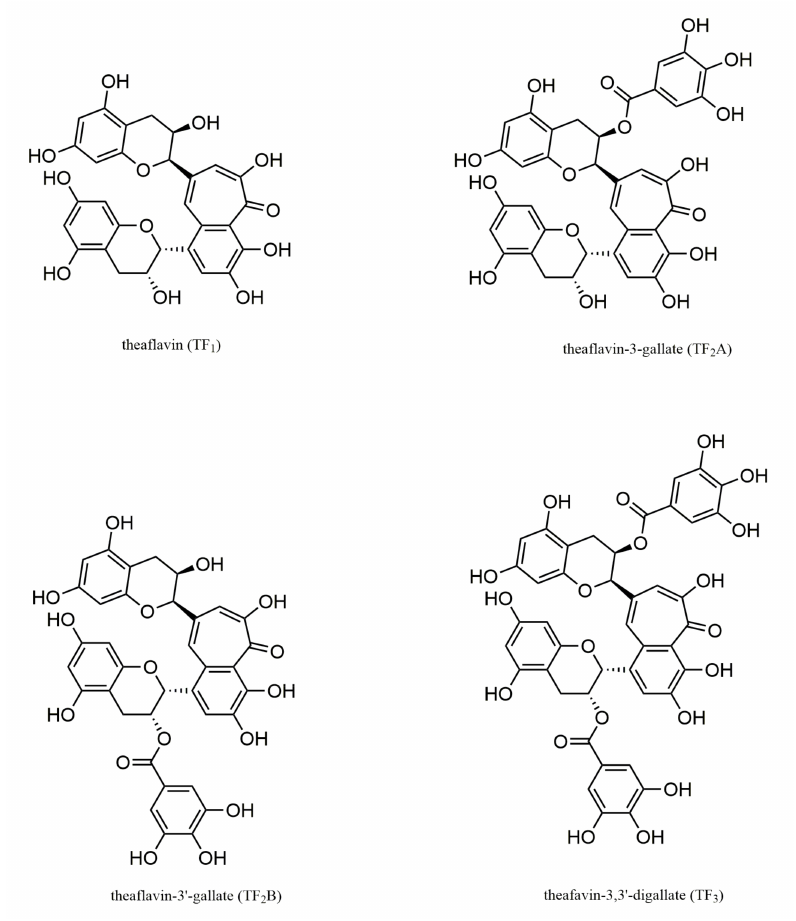
Figure 1. The main monomer forms of